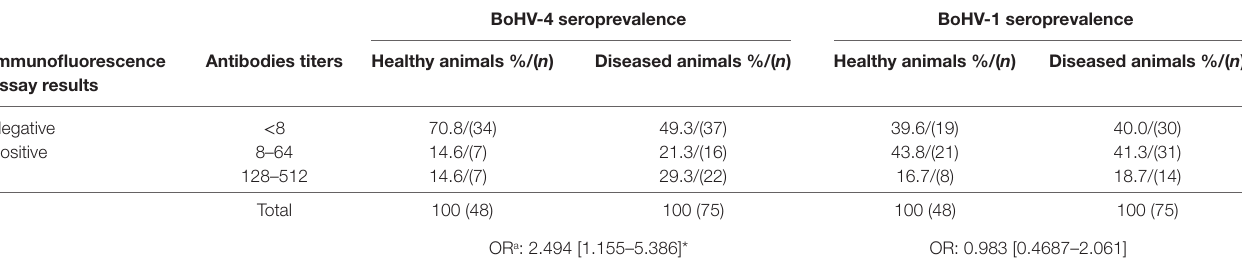
TaBle 2 | Bovine gammaherpesvirus 4 (BoHV-4) and 1 (BoHV-1) seroprevalence in diseased dairy cattle.